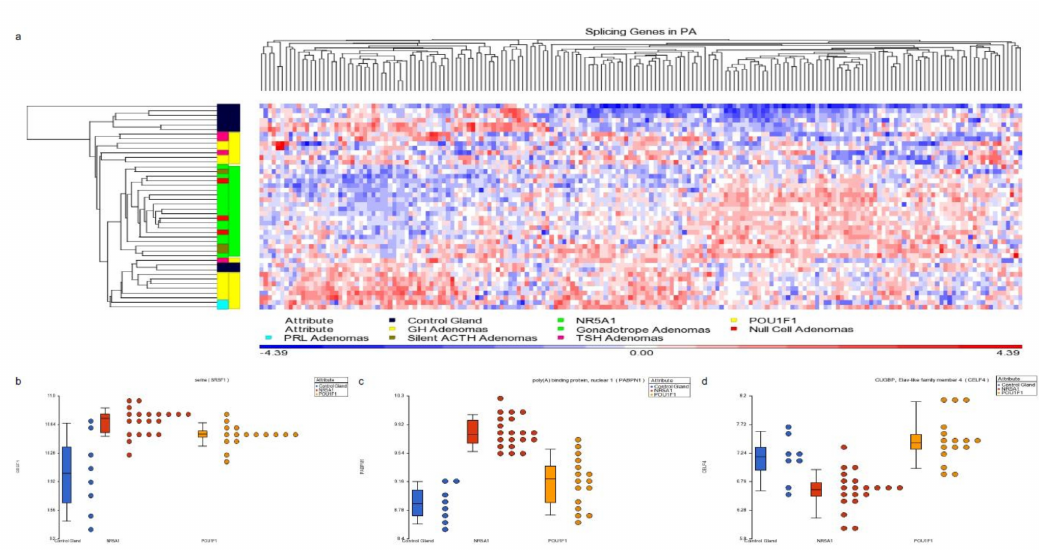
Figure 5. Panel ( a ) hierarchical cluster showing the spliceosome-related genes. NR5A1- and POU1F1- derived tumors show distinctive profiles which di ff erentiate them using spliceosome-related genes. Panels ( b – d ) present dot blots from SRFS1 gene up-regulated in both cell lineages tumors, PABPN1 gene up-regulated predominantly in NR5A1-derived tumors and CELF4 gene up-regulated in POU1F1 tumors, respectively. Blue dots represent the non-tumoral control gland, red dots the NR5A1 tumors and yellow dots the POU1F1